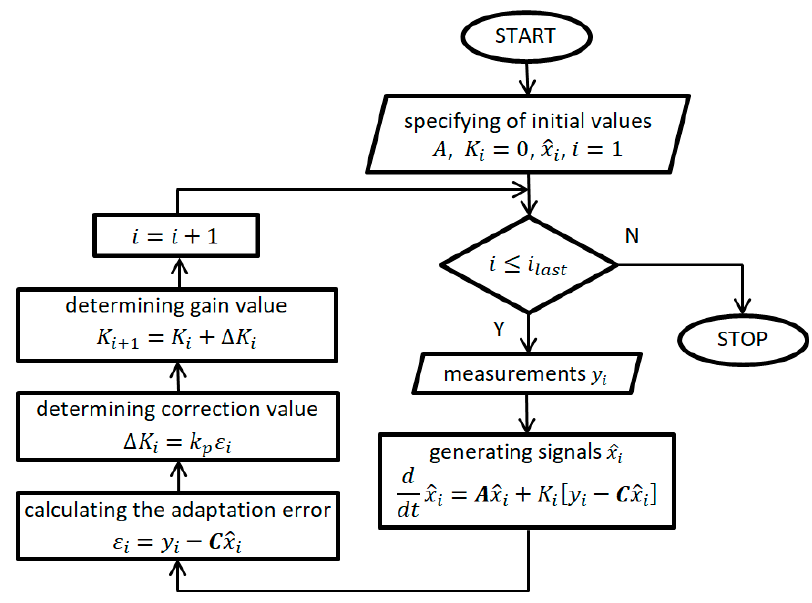
Figure 2. Scheme of the soft sensor algorithm.